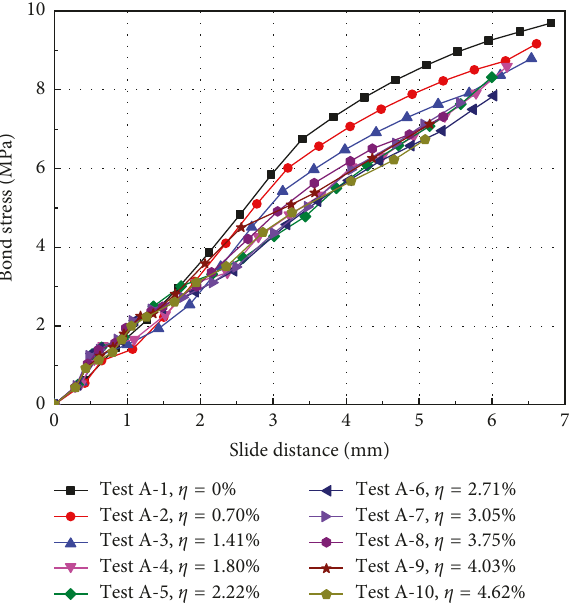
Figure 9: The relationship between bond stress and slide distance obtained in group A.